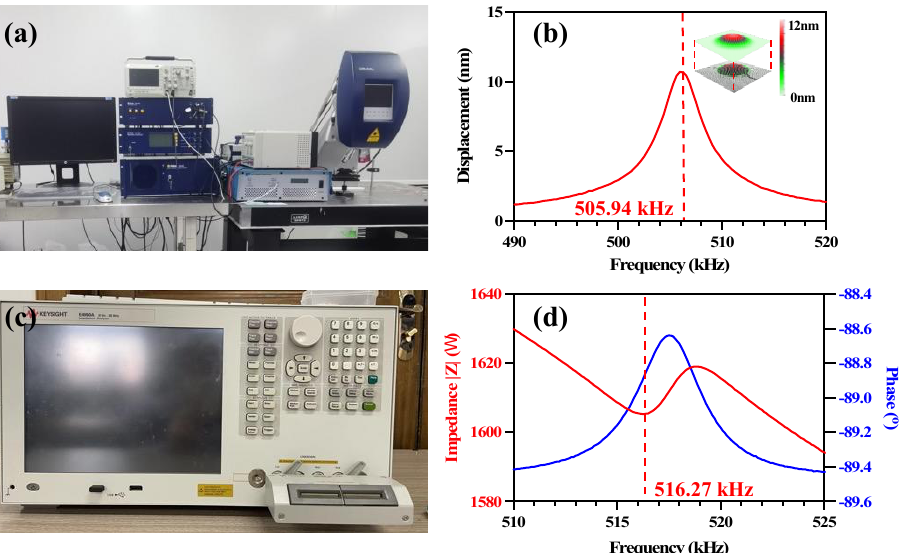
Figure 3. ( a ) The single-point Laser Doppler Vibrometer; ( b ) the displacement–frequency response; ( c ) the impedance analyzer; ( d ) the impedance testing of the PMUT.